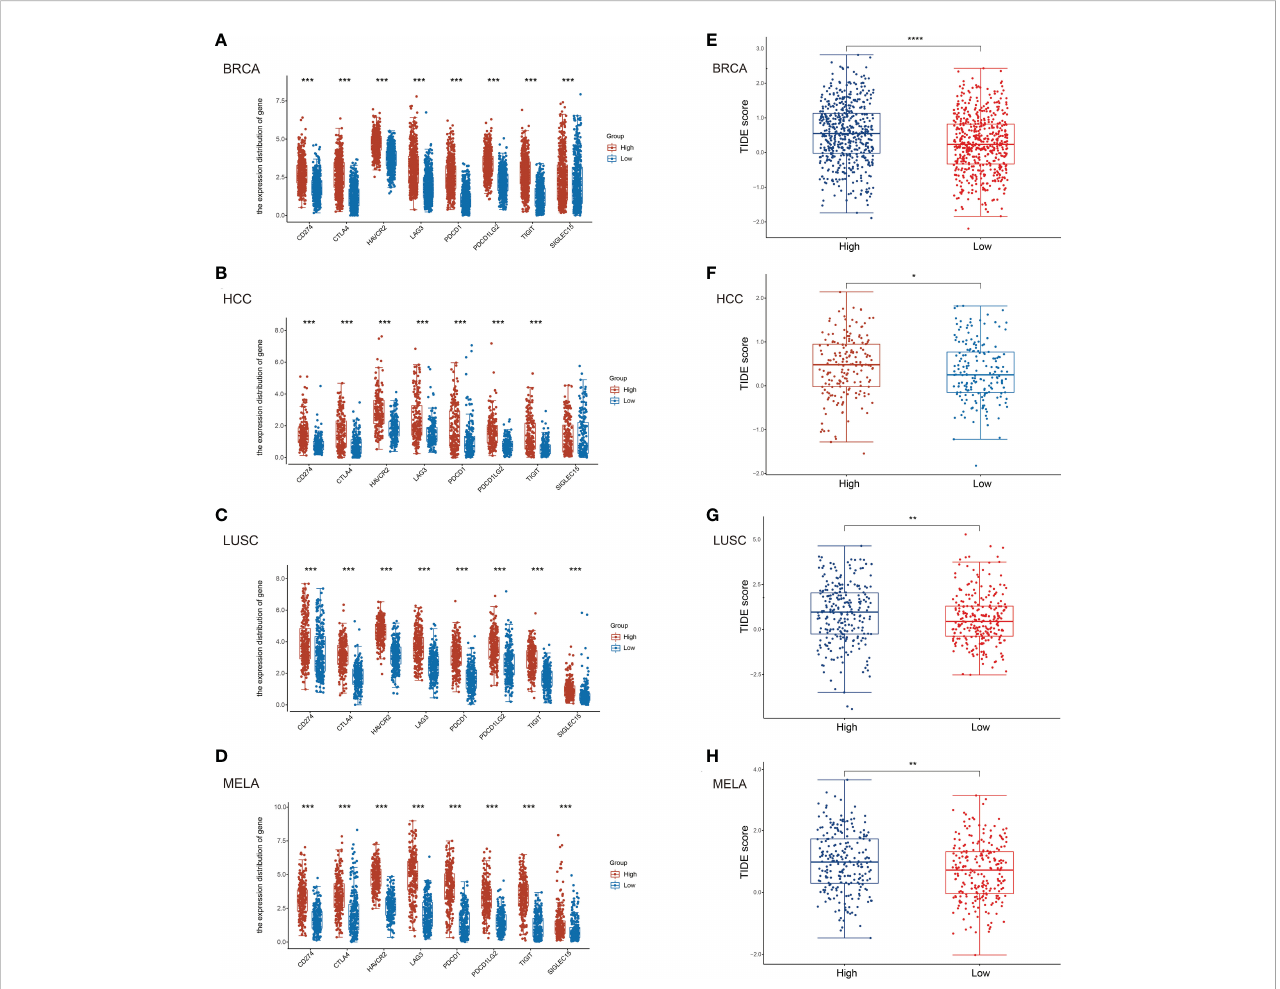
FIGURE 2 Correlation of TNFR2 expression and immune checkpoint gene markers. To predict the correlation between TNFR2 expression and the responses to immune checkpoint inhibitor therapy, (TIDE) score was evaluated. According to the median value of TNFR2 expression, tabulated tumor samples and types (BRCA, HCC, LUSC, and MELA) were divided into TNFR2 high and TNFR2 low groups. Then, TIDE score was used to predict the correlation between TNFR2 expression and immune checkpoint inhibitor responses. The correlation between TNFR2 and representative immune checkpoints gene markers, such as CD274 (PD-L1), CTLA4, HAVCR2, LAG3, PDCD1 (PD-1), PDCD1LG2 (PD-L2), TIGIT, and SIGLEC15 were shown in BRCA (A) , HCC (B) , LUSC (C) and MELA (D) . TIDE score was used to predict the correlation between TNFR2 expression and ICIs responses in BRCA (E) , HCC (F) , LUSC (G) , and MELA (H) . * P < 0.05, ** P < 0.01, *** P < 0.001, **** P <